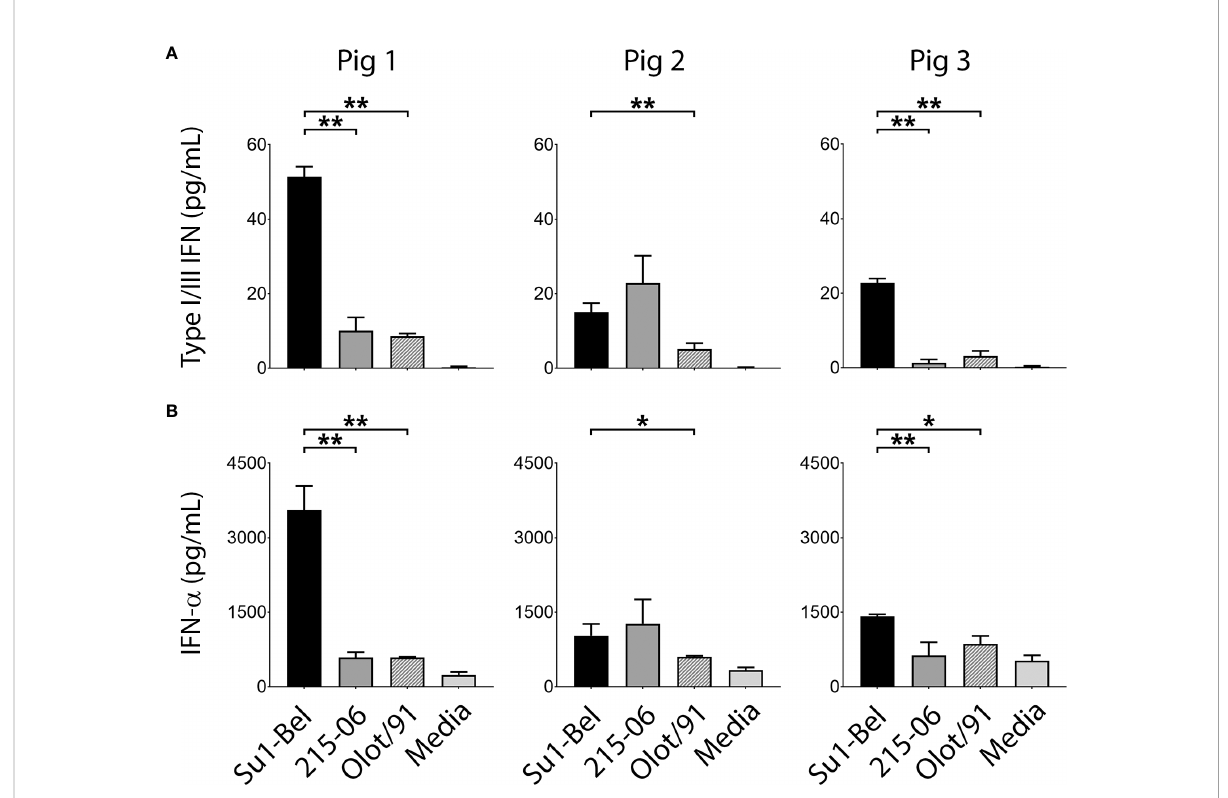
FIGURE 3 SU1-Bel infected BMDM secrete higher concentrations of IFN- a than BMDM infected with 215-06 or Olot/91. BMDM from three pigs were infected (MOI 0.01) with PRRSV-1 strains SU1-Bel, 215-06 and Olot/91 and at 48 hpi supernatants were analyzed using an (A) Mx-CAT IFN assay or (B) a porcine IFN- a ELISA. Experiments were performed on three separate occasions. Data is presented as the mean +/- standard deviation (*p < 0.05, **p < 0.01).